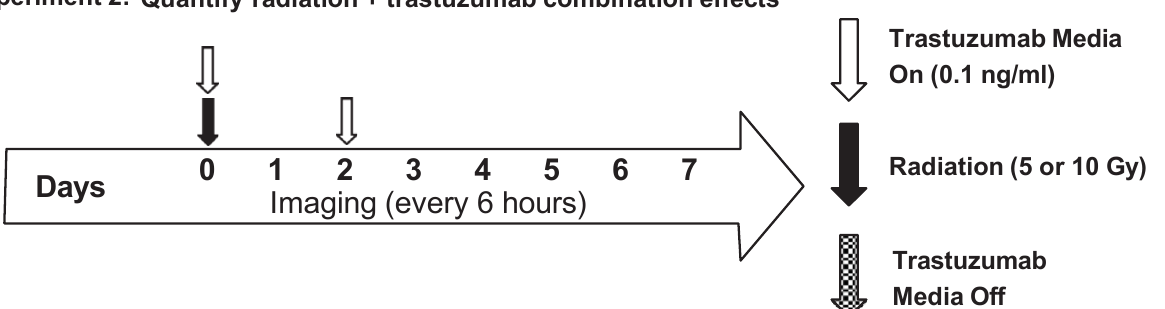
Figure 1. Treatment plans for in vitro experiments. ( A ) Cells were treated with either trastuzumab (0.1 ng/mL) from 0–48 h (1, before radiation), 24–72 h (2, with radiation), or 48–96 h (3, after radiation). All groups received radiation (10 Gy) at 24 h. All groups were imaged every 6 h for seven days. ( B ) Cells were treated with trastuzumab (0.1 ng/mL) and radiation (5 or 10 Gy) at the start of the experiment (Day 0). Trastuzumab was removed 48 h later. Cells were imaged every six hours for seven days.